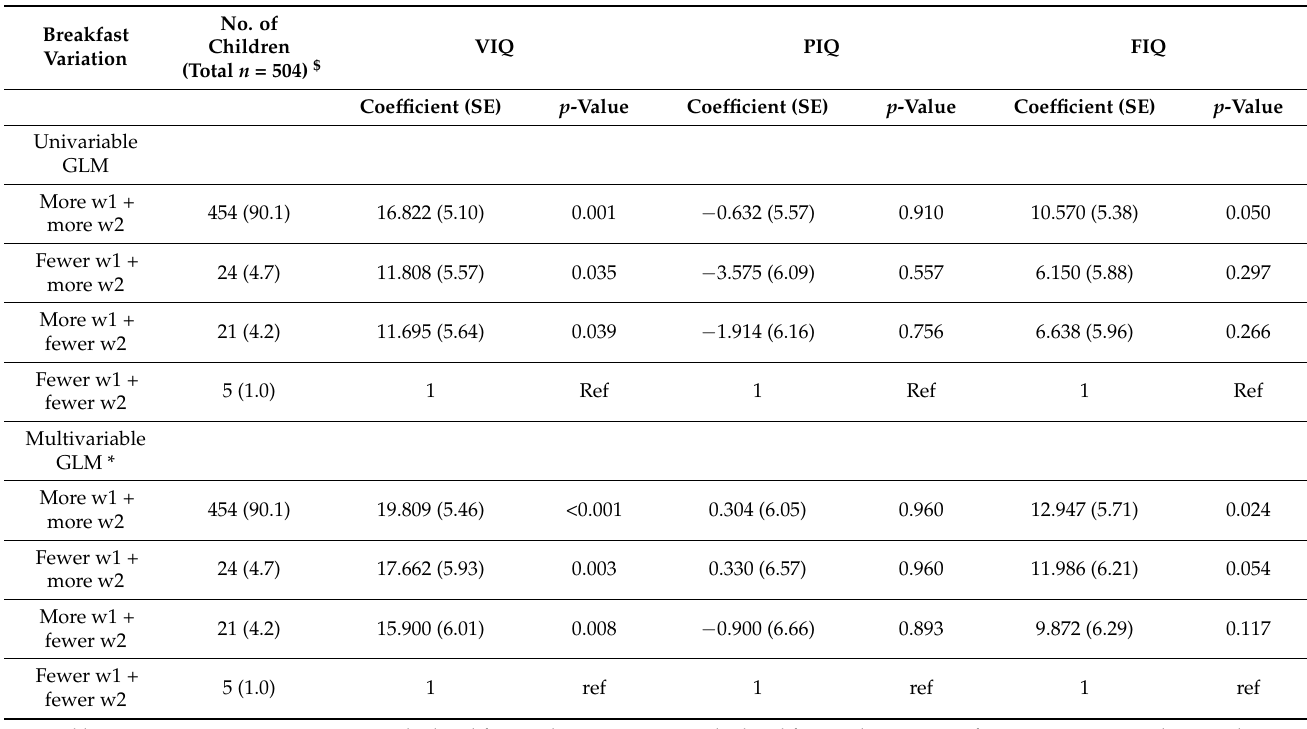
Table 3. Association between categorical breakfast consumption frequency and IQ of the 2nd wave ( n = 504). Breakfast